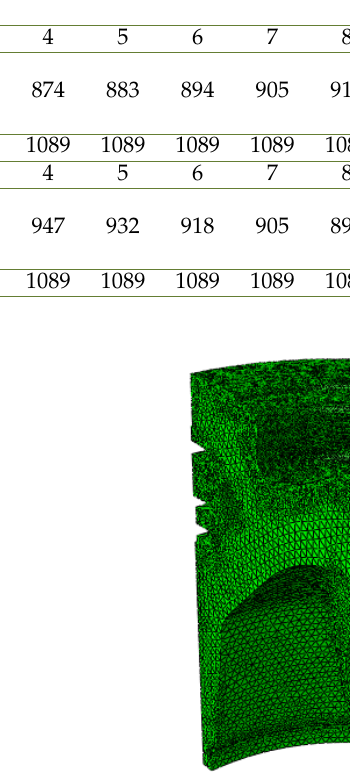
Fig. 3. Schematic diagram of piston top surface division area